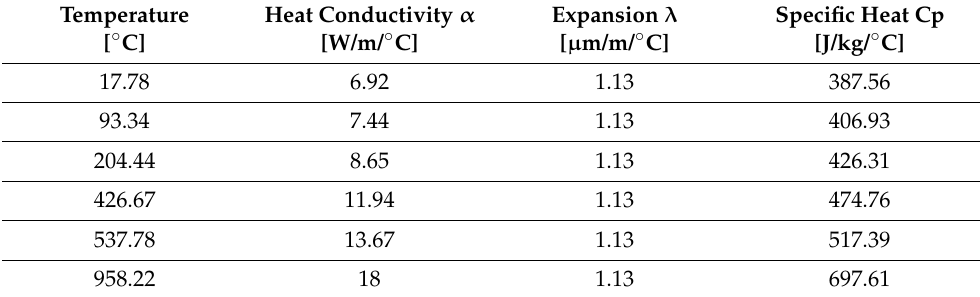
Table 3. Thermal properties of the titanium alloys Ti-6Al-4V [30,31].